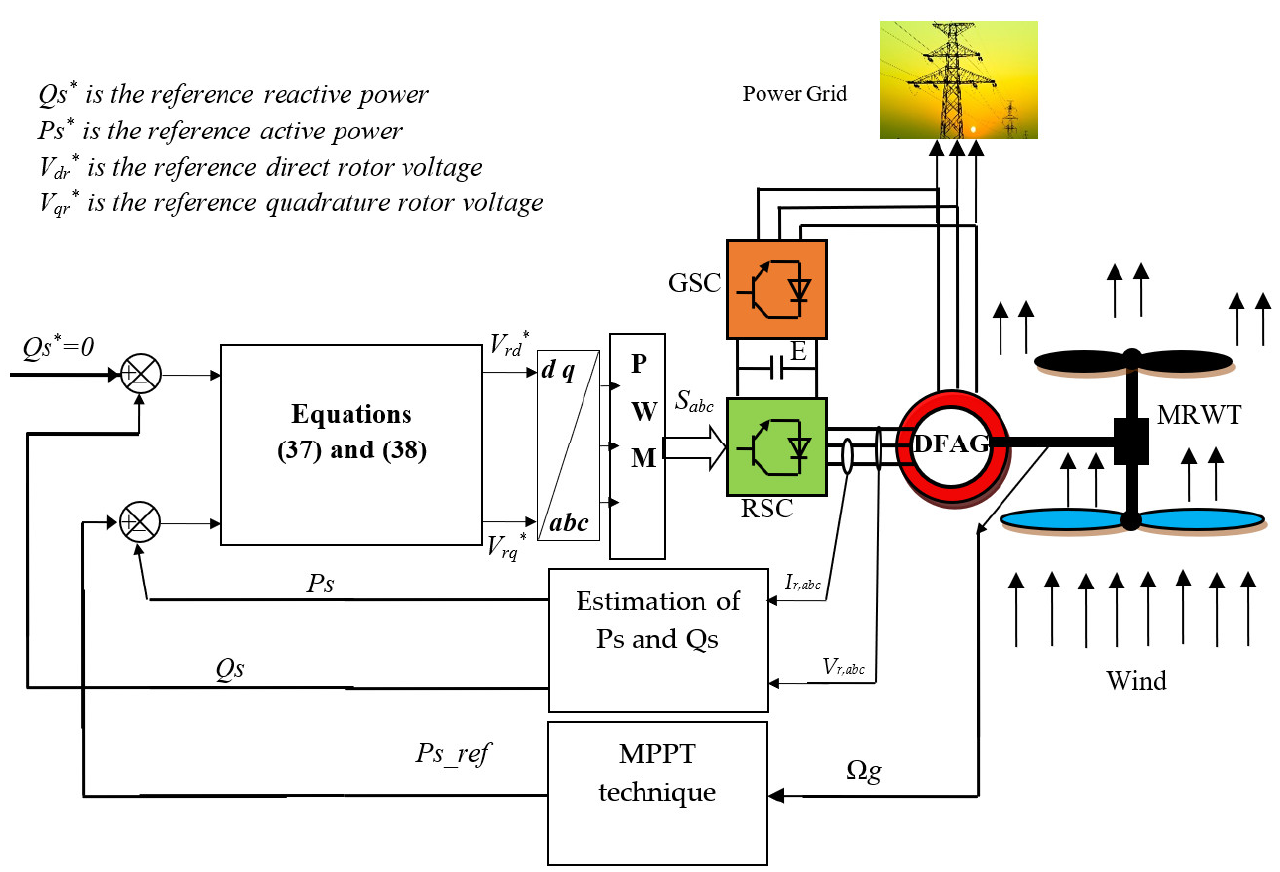
Figure 5. Proposed DPC-MSMC strategy of the DFAG-MWRT system.